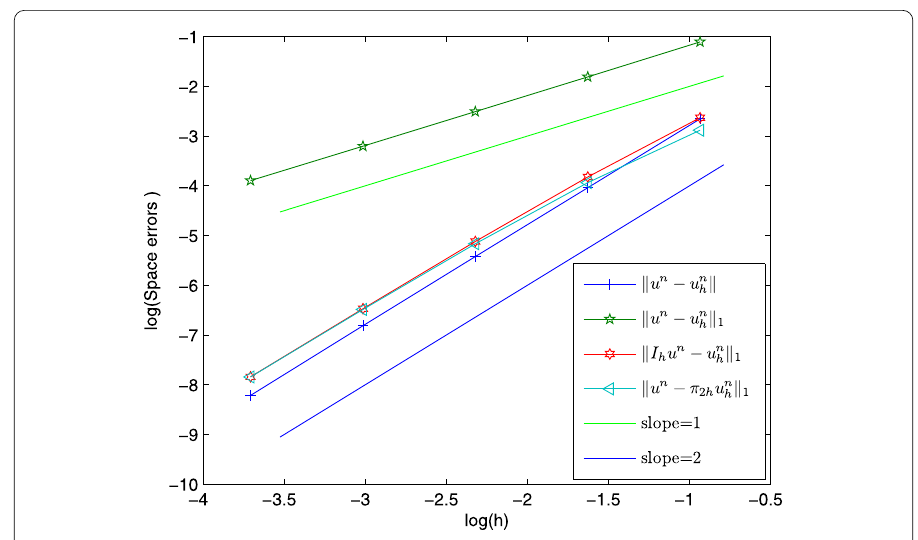
Figure 5 The error reduction in spatial direction of the scheme (8) for Example 3 with α =